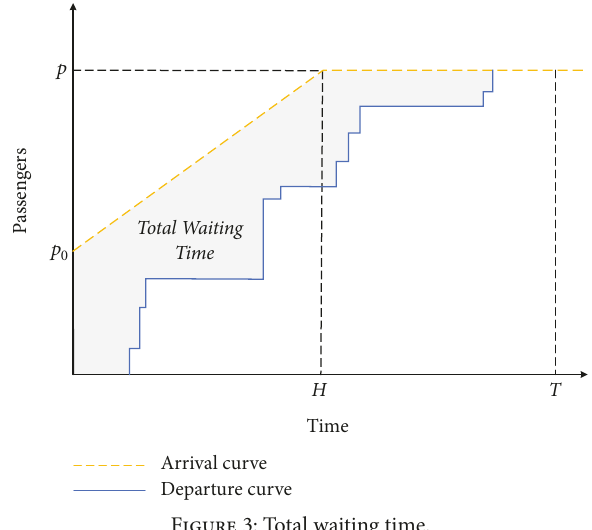
Figure 3: Total waiting